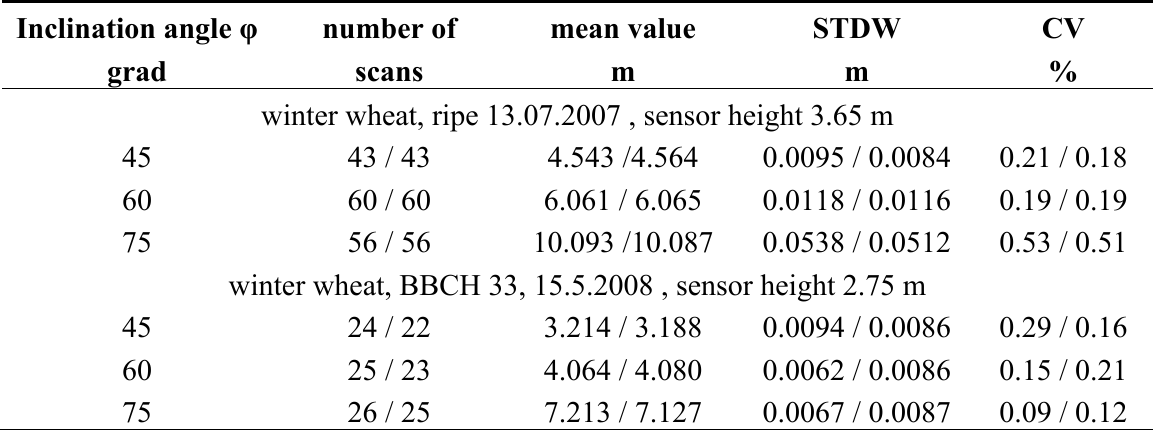
Table 5. Comparison of mean values, standard deviations, and coefficients of variation of reflection distance of scans in ripe and green winter wheat (forward / reverse